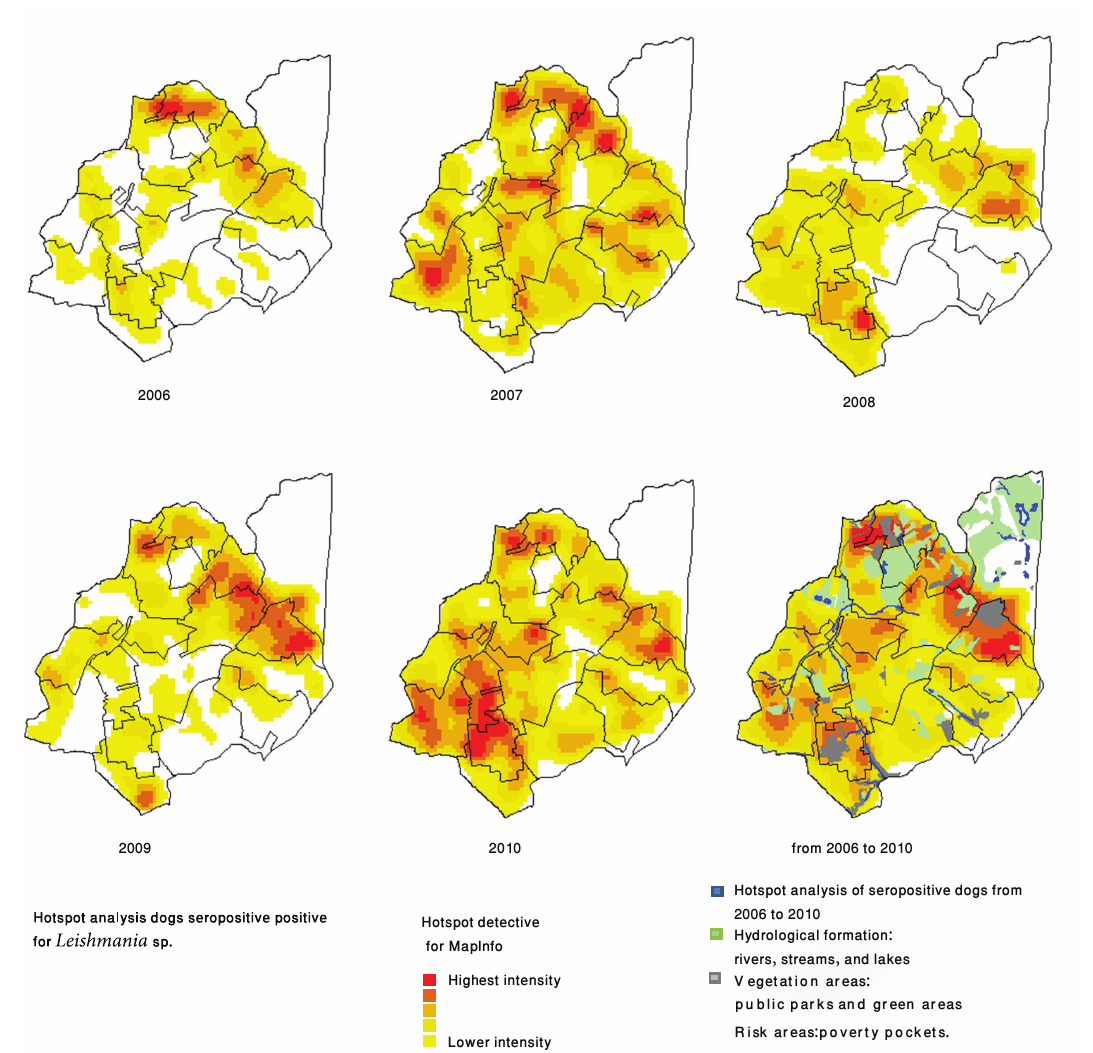
Figure 3: Dogs seropositive for Leishmania sp. in serosurveys carried out in SD Venda Nova from 2006 to 2010, the results shown georeferenced positive samples and clusters analysis for each